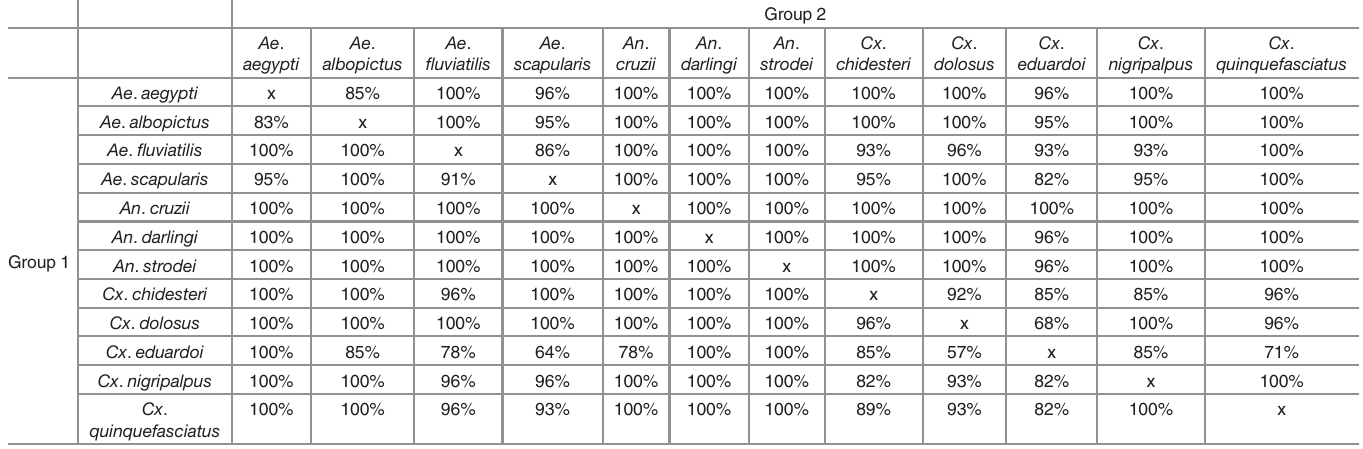
Table 2. Results of pairwise cross-validated species reclassification